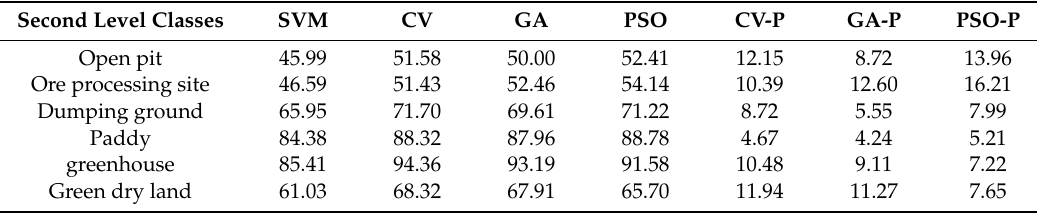
Table 6. Classification accuracy of di ff erent methods